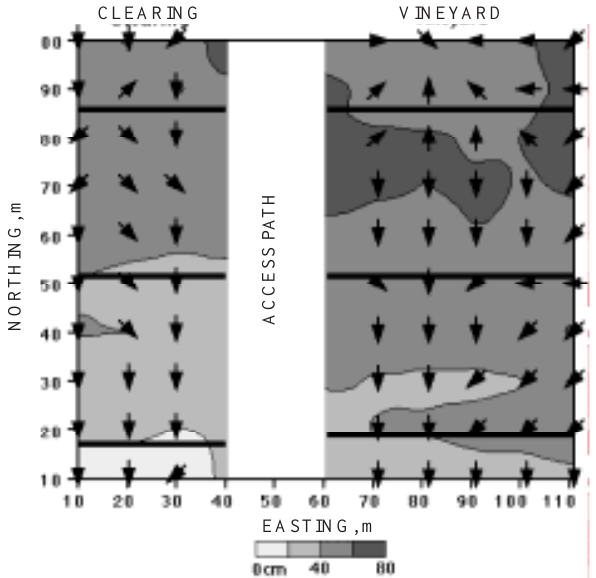
Figure 1. Surface elevation map of the Fazenda Garibaldina study site. The lowest relative elevation measured is taken as the local datum. Arrows indicate slope direction calculated from the digital elevation model by the program TOPO (see text); thick parallel lines represent collector canals.